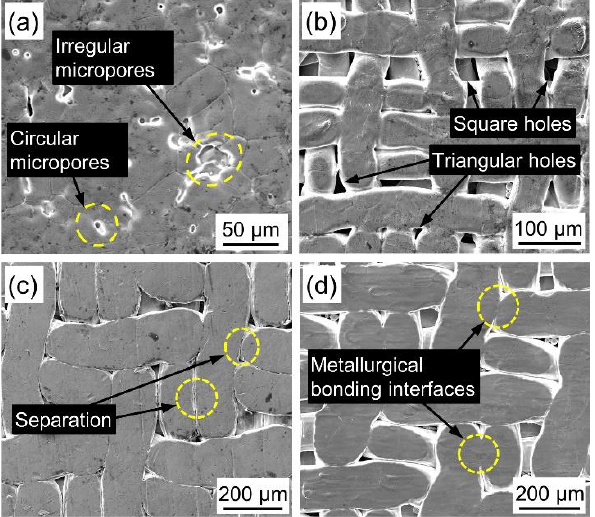
Figure 2. Surface topography of PWMCPPs. With ( a ) 12.45% volume fraction; ( b ) 50 μm wire mesh diameter; ( c ) 1160 ° C sintering temperature; ( d ) 1360 °C sintering temperature. diameter; ( c ) 1160 ◦ C sintering temperature; ( d ) 1360 ◦ C sintering